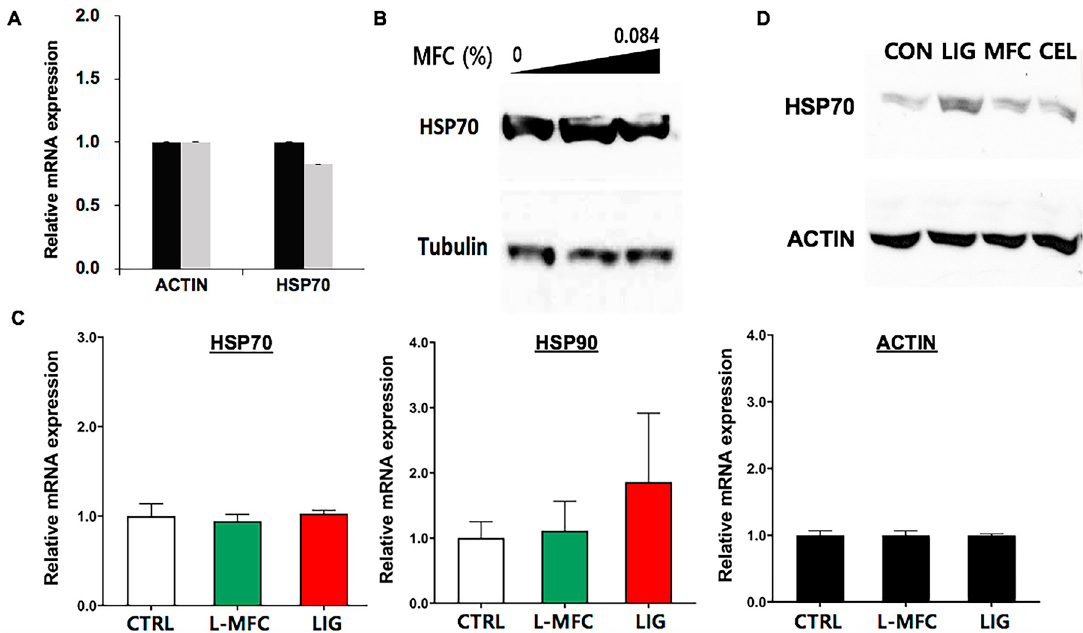
Figure 4. Analysis of the expression of Heat shock proteins, HSP70 and HSP90 in cellulose-, L-MFC-, and lignin-treated HEK293 and H460 cells. ( A ) qRT-PCR results showing HSP70 mRNA expression in L-MFC-treated HEK293 cells. Black bars, untreated control, gray bars, L-MFC-treated cells. Error bars, s. d. (n = 3). β -ACTIN was used as a reference gene in all qRT-PCR analyses in this study. ( B ) Immunoblotting results probing HSP70 in L-MFC-treated HEK293 cells. Tubulin, a loading and reference control. ( C ) qRT-PCR results probing HSP70 (left), HSP90 (middle), and ACTIN (right, reference gene) mRNA in L-MFC- or pure lignin-treated H460 cells. CTRL, negative control; LIG, pure lignin. Error bars, s. d. (n = 3). ( D ) Western blotting results probing HSP70 in cellulose, L-MFC-, and lignin-treated H460 cells. CON, negative control; Lig, pure lignin; MFC, L-MFC; CEL,